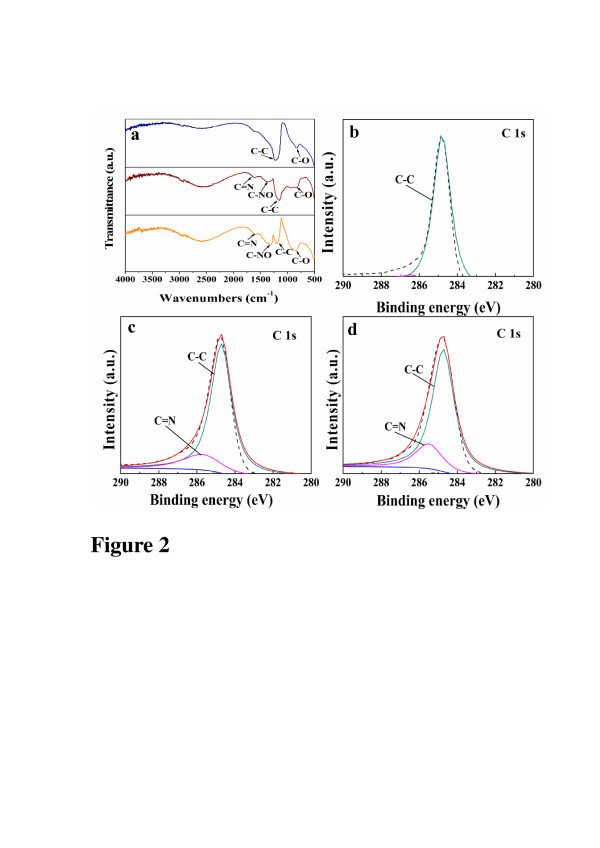
Transmission spectra of MWCNTs and NH2/MWCNTs. (a) FTIR spectra of pristine MWCNTs and NH2/MWCNTs with 5 × 1014 and 1 × 1016 ions/cm2. C1s XPS spectra obtained from (b) pristine MWCNTs, (c) NH2/MWCNTs with 5 × 1014 ions/cm2, and (d) NH2/MWCNTs with 1 × 1016 ions/cm2.